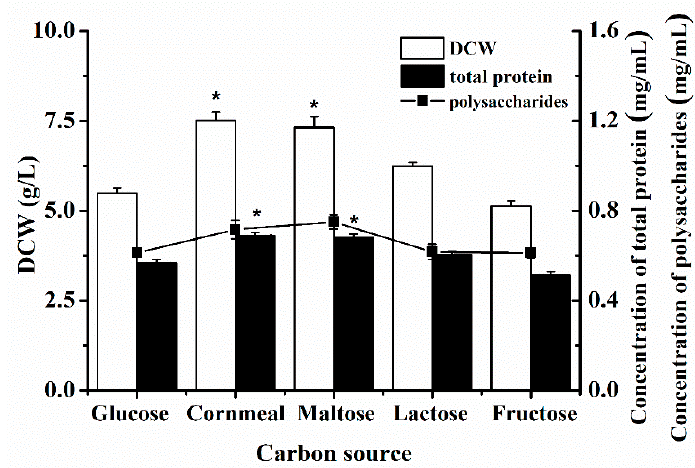
Figure 1. The effect of the carbon source on the DCW, total protein, and polysaccharides of P. eryngii -3 in shake flask. * Indicates statistical significance ( p < 0.05). Data points are the average of n = 3; error bars represent the standard error of the mean. The samples were harvested at 216 h of fermentation.